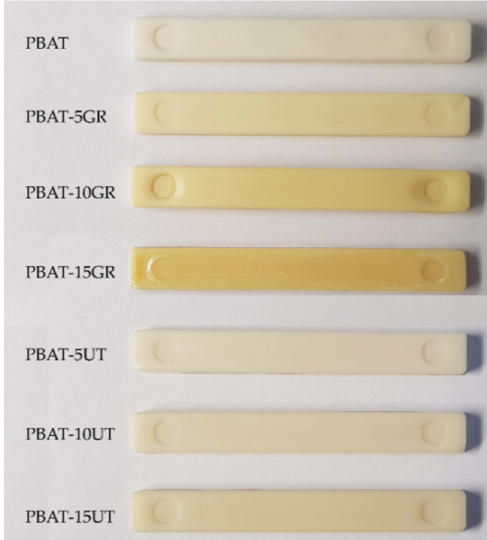
Figure 6. Samples visual appearance of PBAT, PBAT-GR and PBAT-UT formulations obtained by injection moulding.